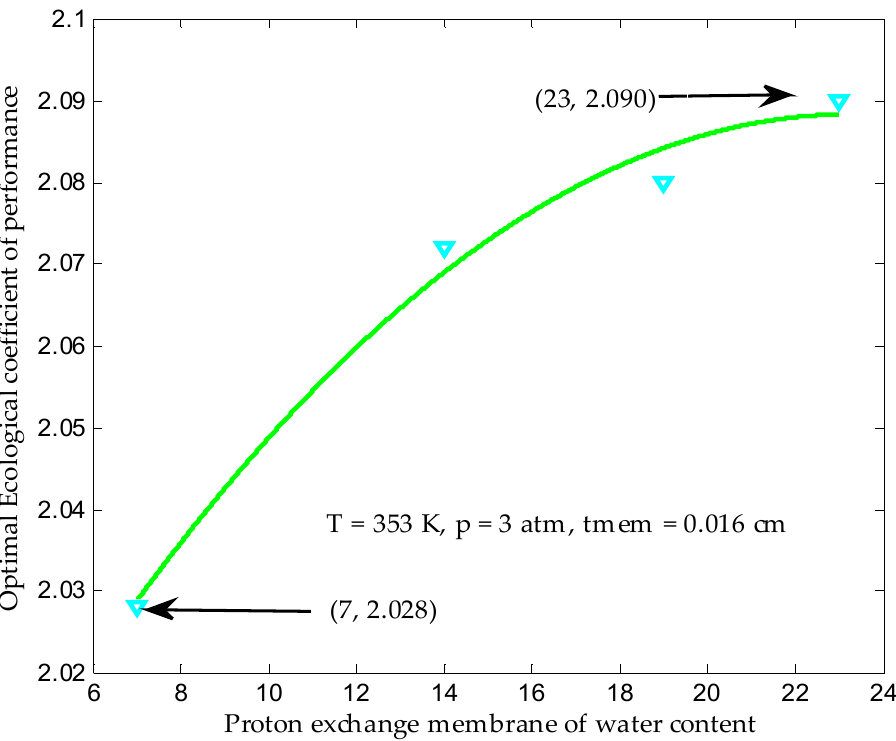
Figure 18. Optimal ECOP varying with membrane water content.